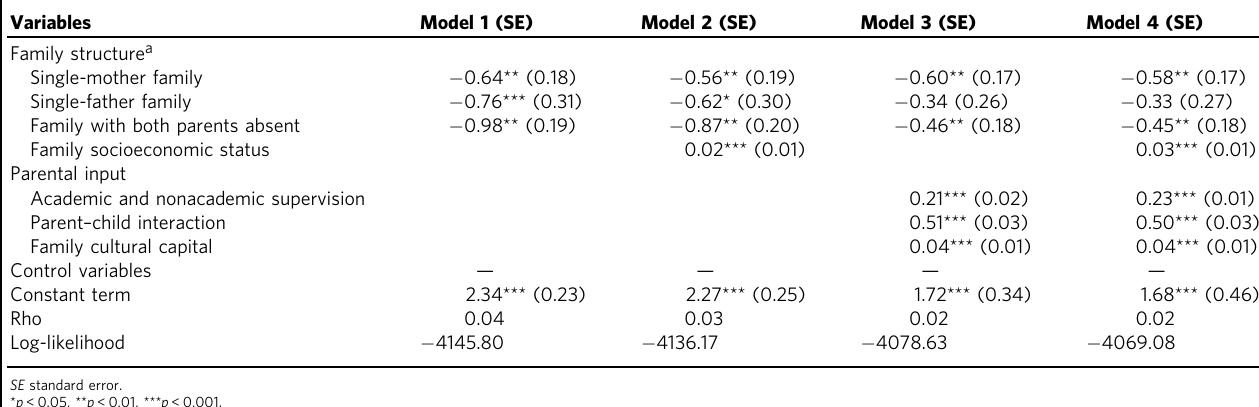
Table 2 Fixed-effect model for estimating physical exercise (PE) ( N = 8459).